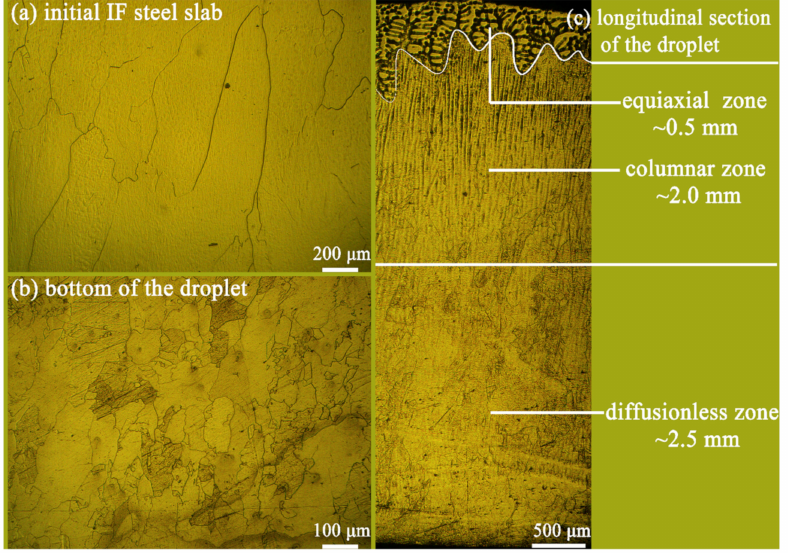
Figure 5. Microstructures of IF steel samples: ( a ) initial IF steel slab, ( b ) bottom, and ( c ) longitudinal section of the solidified droplet. ( a , b ) were etched by nitric acid and ( c ) were etched by picric